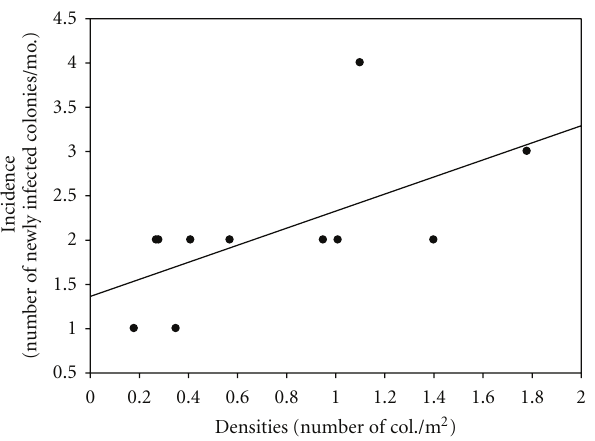
Figure 3: Spearman correlation analysis between densities of M. faveolata and incidence of CYBD on the di ff erent reefs ( ρ = 0 . 70; P = 0 . 01).